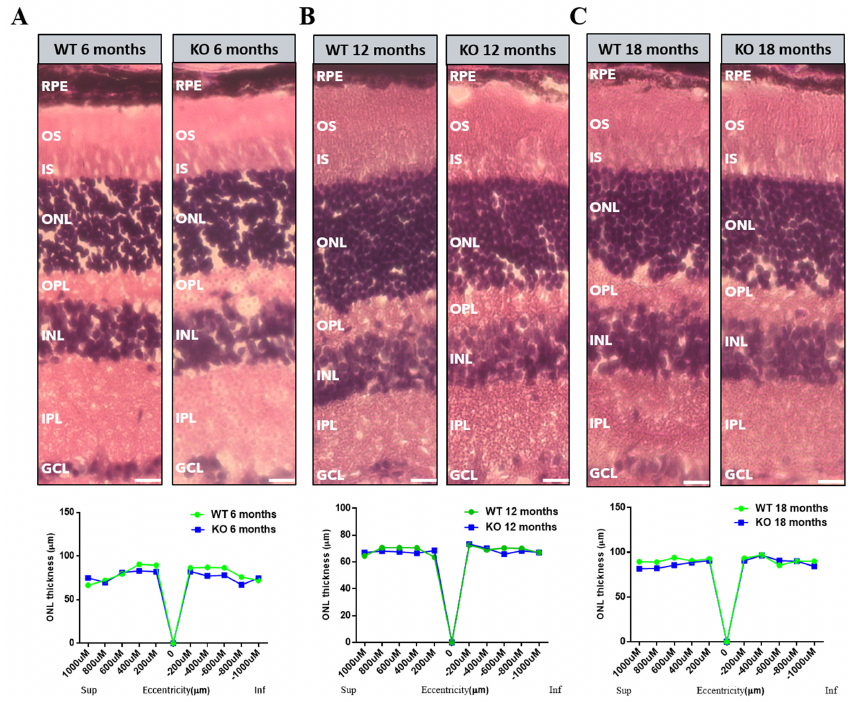
Figure 1. Retinal morphology in WT and Tspo KO mice. Histological examination with haematoxylin and eosin staining showing normal retinal morphology and no significant difference in thickness of outer nuclear layer (ONL) in WT and Tspo KO mice at 6 ( A ), 12 ( B ) and 18 mon ( C ) of age. Graphs show the thickness of ONL on both the superior (Sup) and inferior (Inf) sides of the retina ( n = 5). INL: inner nuclear layer; IPL: inner plexiform layer; ONH: optic nerve head; ONL: outer nuclear layer; OPL: outer plexiform layer; RPE: retinal pigment epithelial cells. Data were collected from three in- dependent experiments and analyzed by two-way ANOVA followed by Bonferroni test: NS: no significance; *** p < 0.001, **** p < 0.0001. Scale bar, 10 µm.